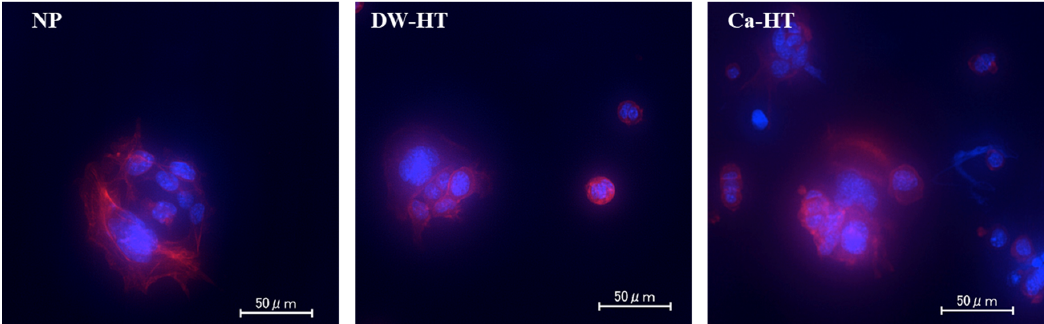
Figure 6. Fluorescent microscopic observation of GE1 cells seeded onto the substrata. After 12 h of incubation, cells were proliferating. There were no significant differences among the three groups. After 1 h of incubation, MC3T3-E1 cells seeded onto DW-HT or Ca-HT plates predominantly exhibited spreading and expansion of cell processes. Some cells were also spread on the NP plates;